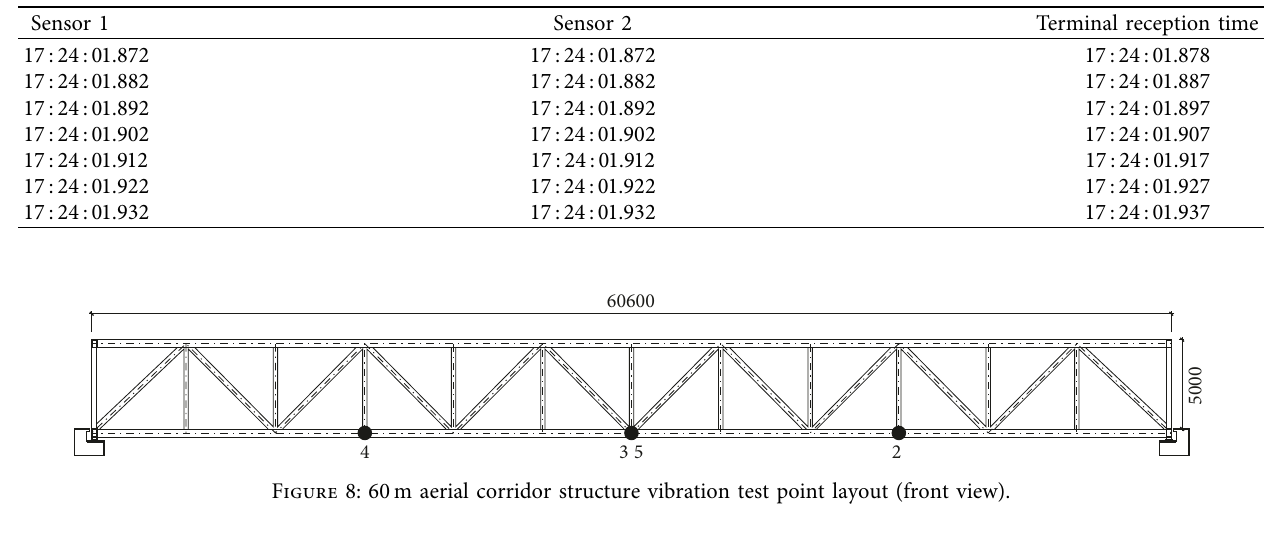
Table 4: Sensor real-time clock times.